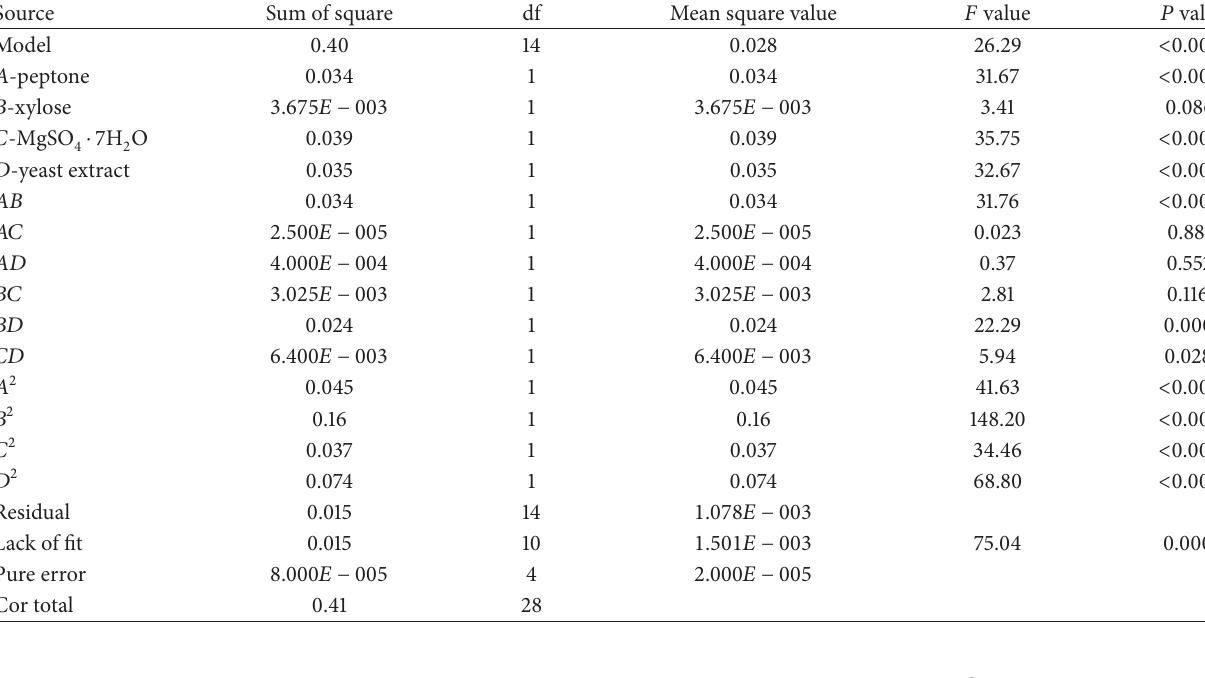
Table 4: Analyses of variance (ANOVA) for response surface quadratic model for the production of xylitol using Box-Behnker design.